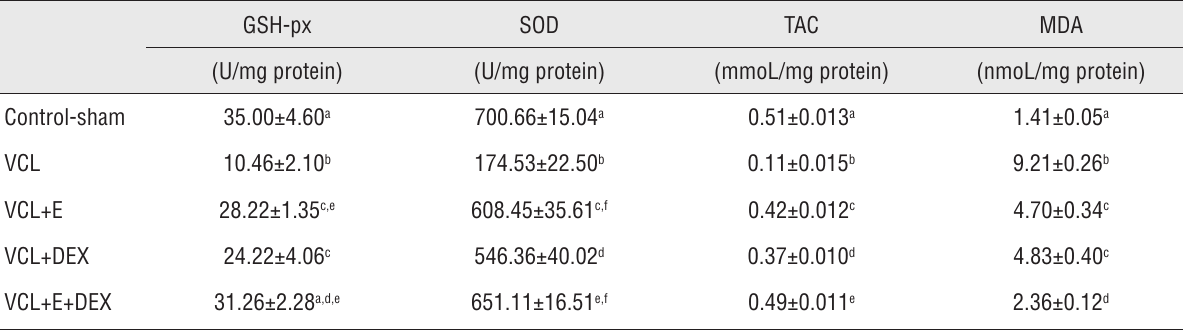
Table 3 - Effect of Vit E and DEX on VCL-induced changes in antioxidant status and MDA level; all data are given as Mean±SD (n=6). GSH-px SOD TAC MDA (U/mg protein) (U/mg protein) (mmoL/mg protein) (nmoL/mg protein) Control-sham 35.00±4.60